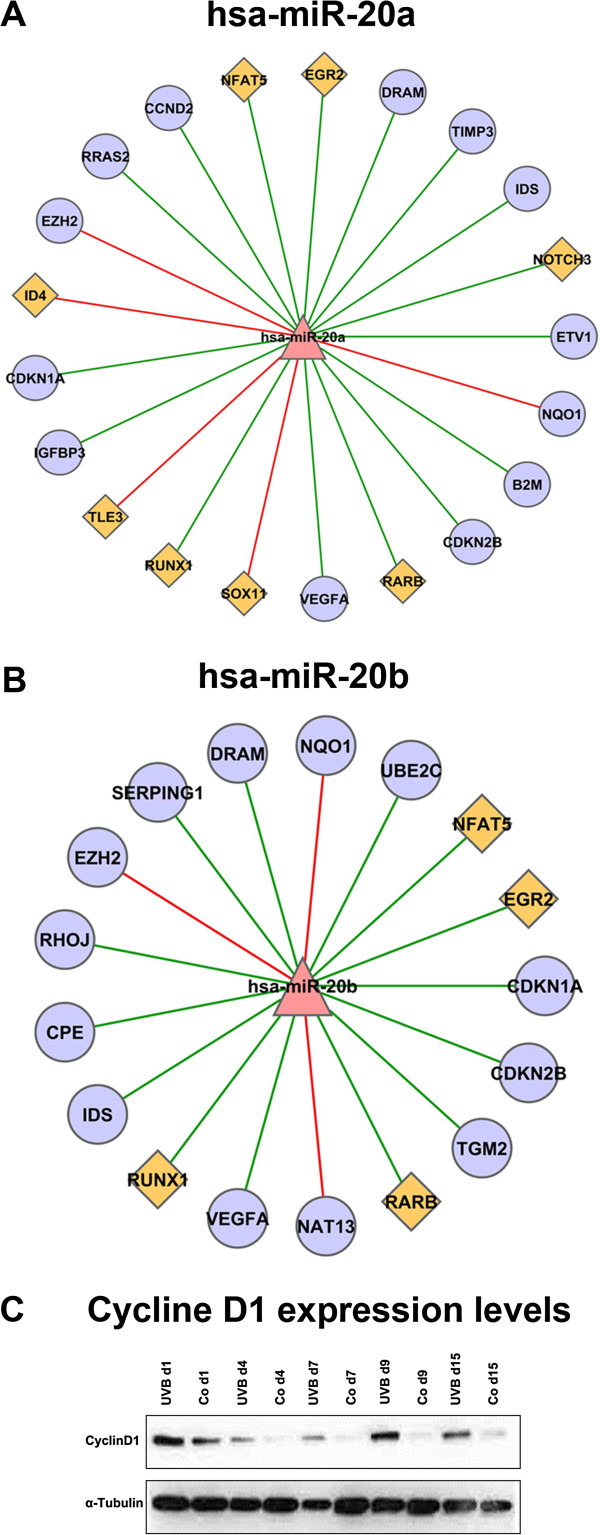
Correlation network of miR-20a/b and their high confidence target genes. We used 10 prediction tools to obtain, based on public data, candidate miRNA-mRNA target interactions and we identified high confidence targets by mRNA and miRNA expression. In positive cases, miRNA expression should show a negative correlation with the respective target gene mRNA level. We calculated Pearson correlation coefficients between miRNAs and their targets. Results of the analysis are presented here for miR-20a (A), and miR-20b (B). The color and shape of nodes are based on different node attributes available for the analyzed dataset. The red triangles, purple circles and orange diamonds in the network are indicating miRNAs, target genes, and transcription factors, respectively. Edges represent correlation between miRNAs and mRNAs, the color of the edges designate the type of interaction. Red is for positive and green is for negative correlation. Protein was isolated from UVB irradiated and control cells at the indicated time points. Protein levels were analyzed by standard Western blot for Cyclin D1 (C). Experiments were performed in triplicates, one representative experiment is shown.